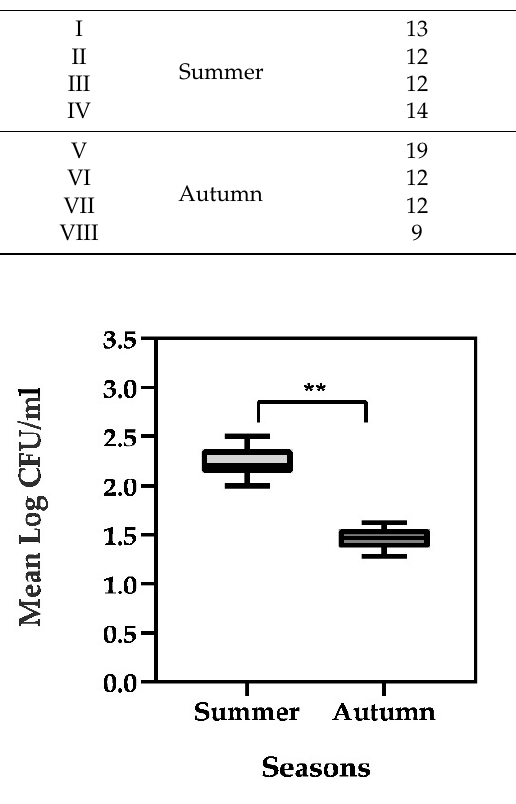
Figure 2. Bacterial load mean (Log CFU/mL) of vegetative cells isolated in processed cheeses during summer and autumn season. Each boxplot represents the result of a mean of sixteen batches, n = 16. Statistical analyses are based on the Wilcoxon test. Asterisks indicate significant differences among groups, **: p < 0.001.